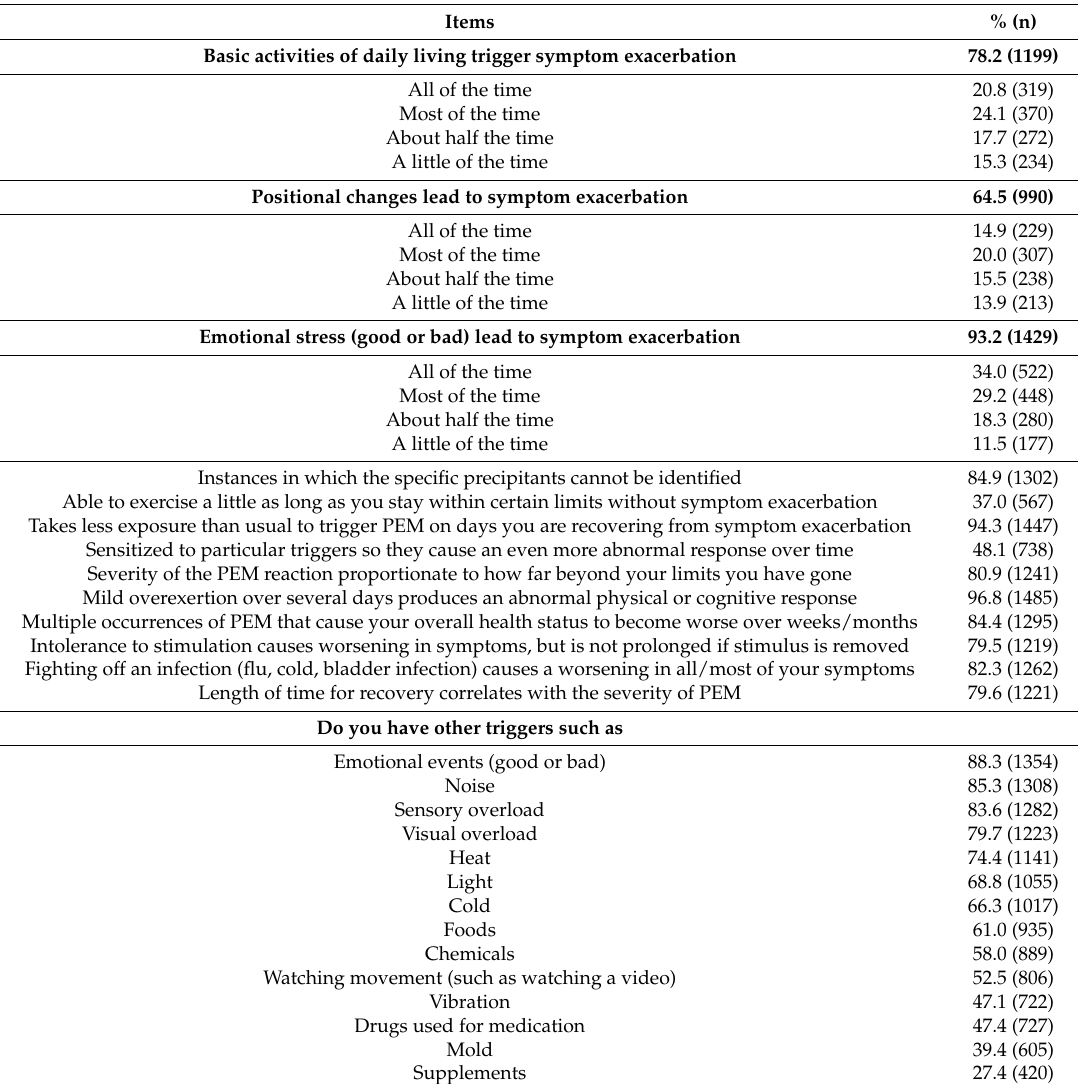
Table 3. Triggers ( N =